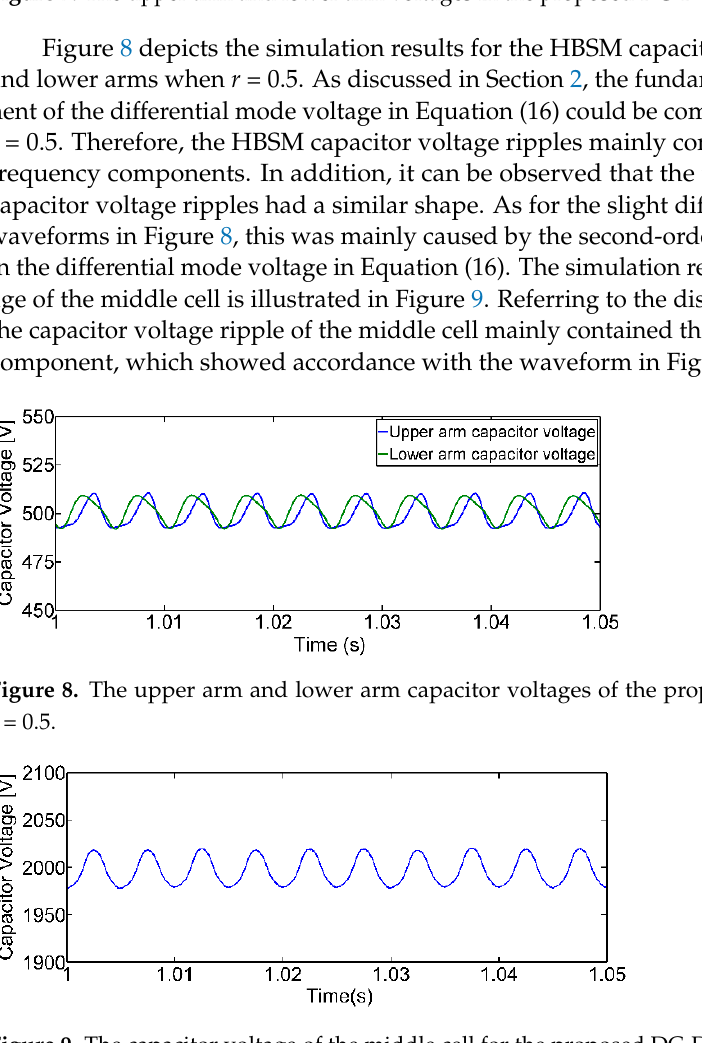
Figure 9. The capacitor voltage of the middle cell for the proposed DC-DC MMC.